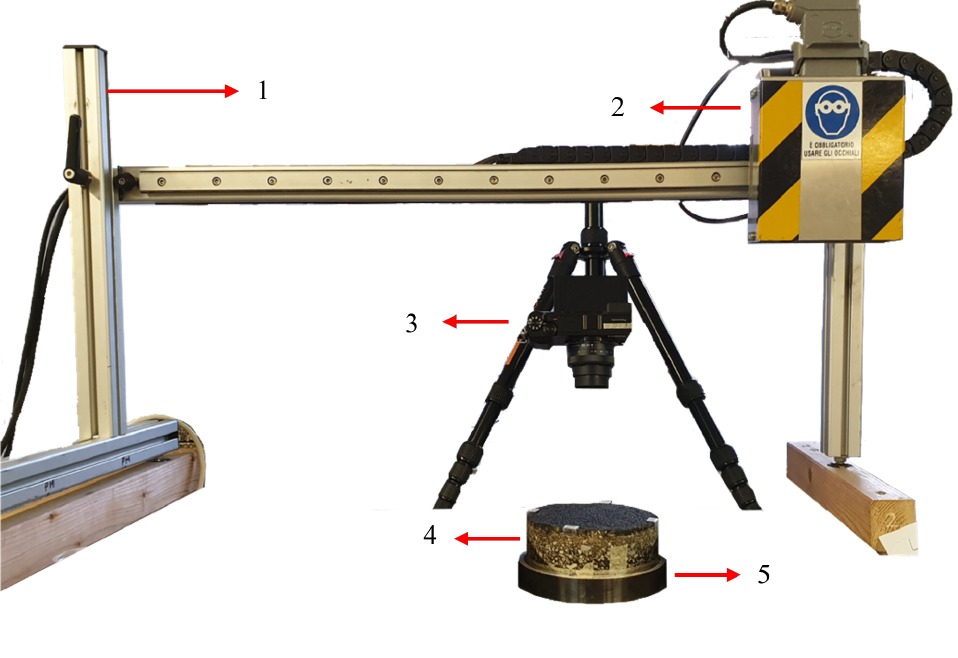
Figure 3. Experimental Set-Up. From Top to Bottom: ( 1 ) Fixed Beam. ( 2 ) Laser Box. ( 3 ) Camera and Tripod. ( 4 ) Sample. ( 5 ) Sample